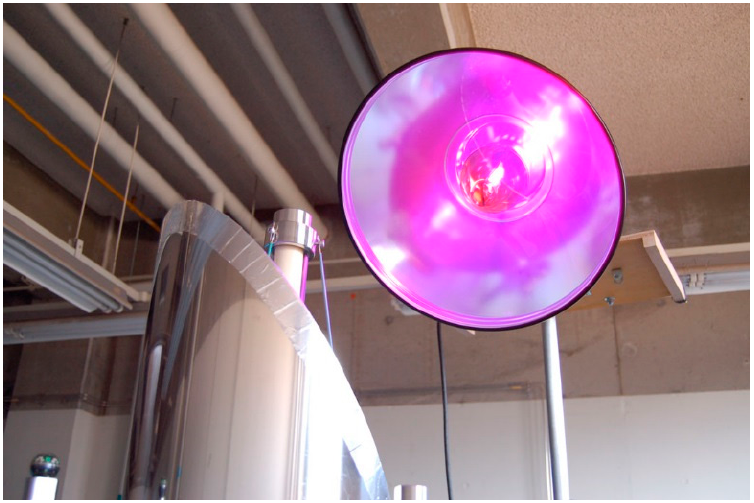
Figure 13. Artificial UV-A